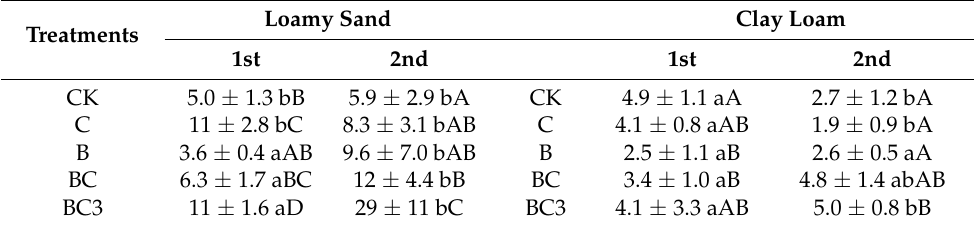
Table 6. PUE of the crops (kg kg − 1 ). Treatments